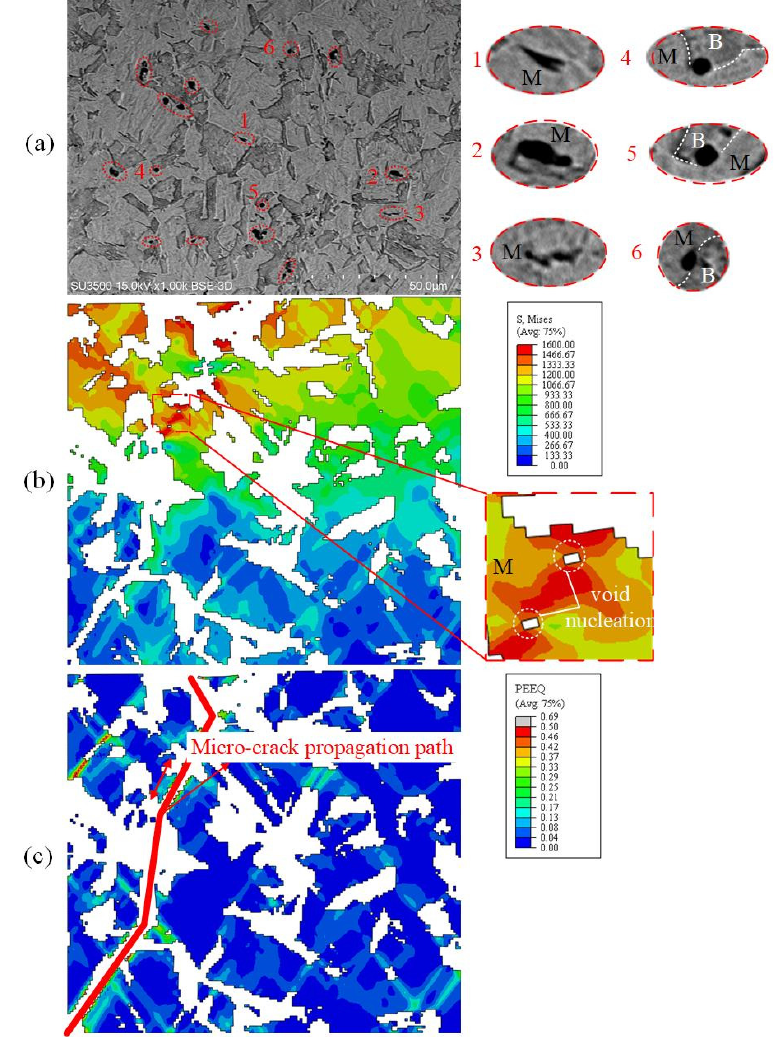
Figure 23. Comparison between SEM and simulation of 30%B + 70%M uniaxial tensile specimens: ( a ) SEM micrographs of damage mechanisms; ( b ) von Mises equivalent stress during void nucleation; ( c ) PEEQ at complete